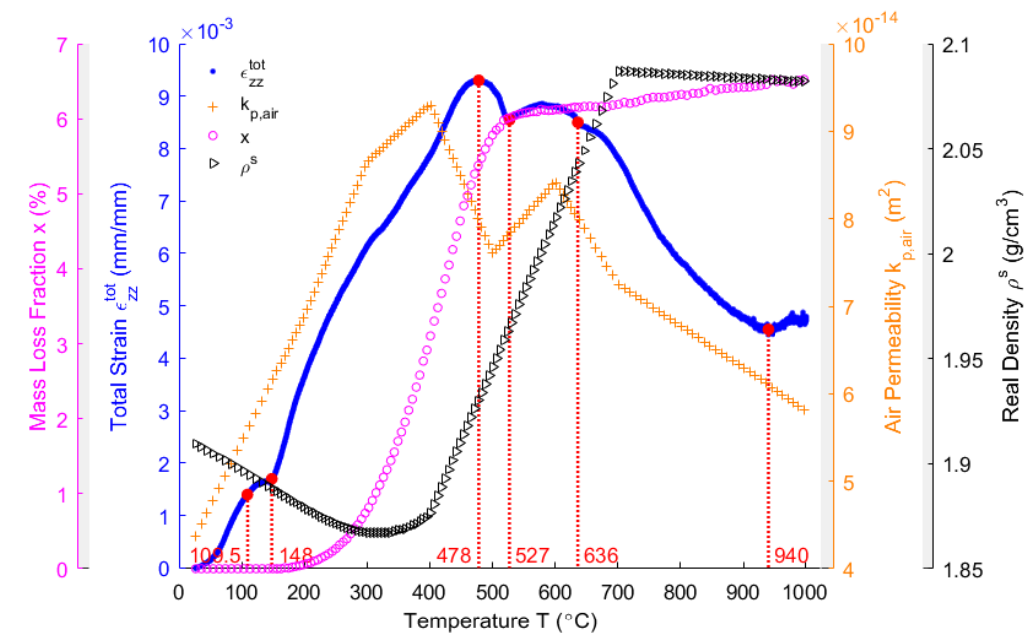
Figure 9. Evolution of the total strain of the anode sample in the vertical direction, the mass loss fraction, the air permeability, and the real density of the anode sample.